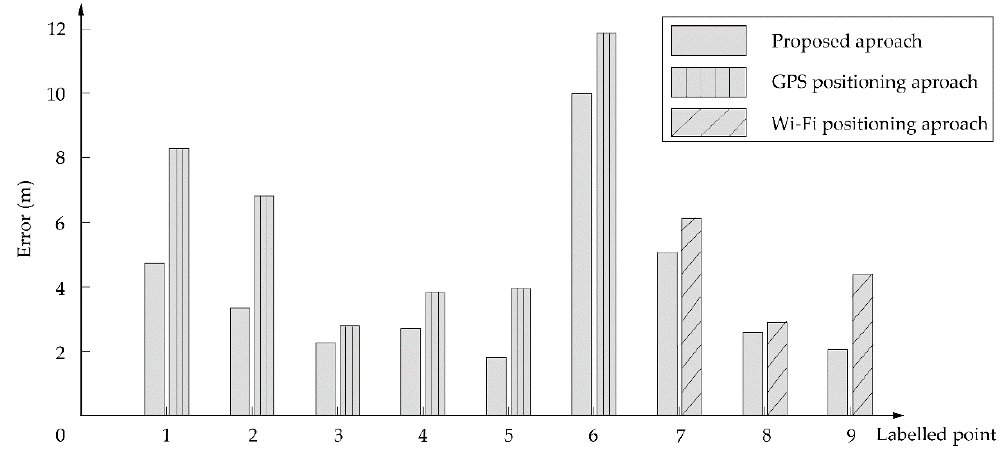
Figure 13. Positioning errors of labelled points.